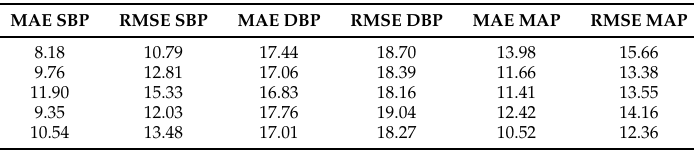
Table 7. Models hyperparameters